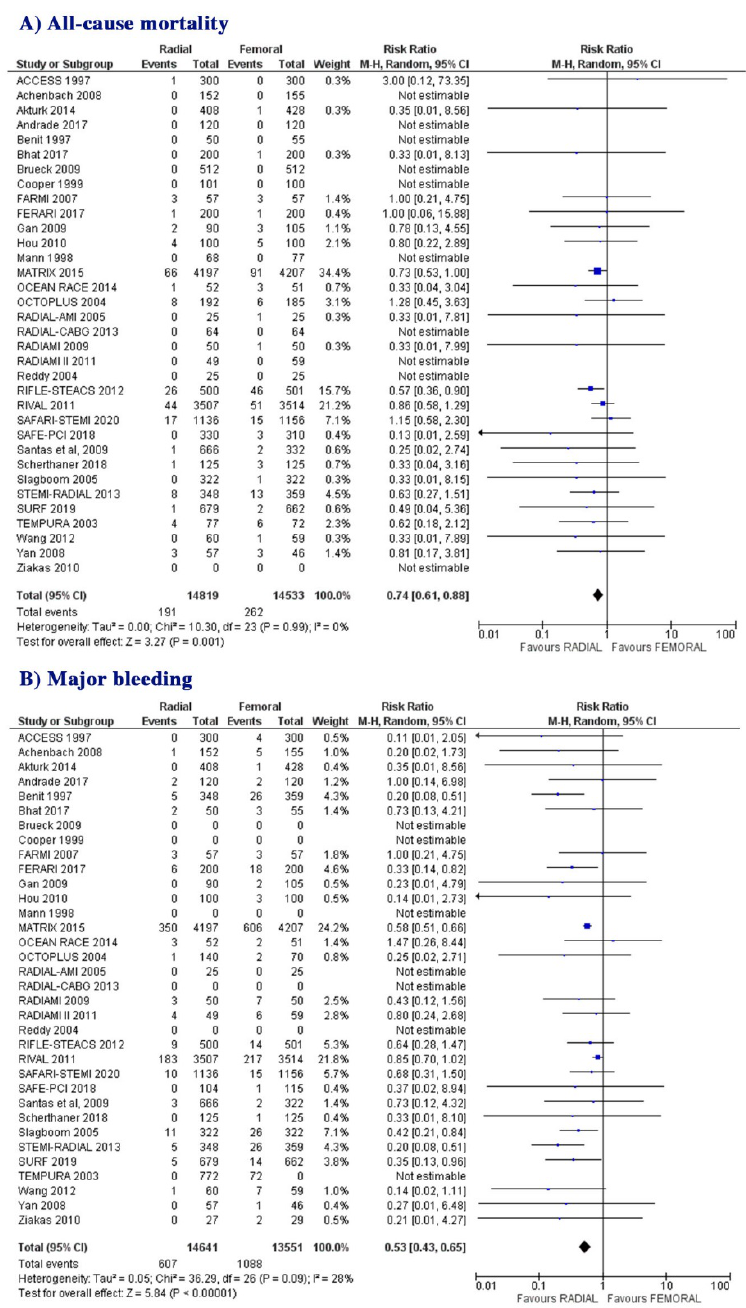
Figure 2. Risk of all-cause mortality ( A ) and major bleeding ( B ) at follow-up: radial vs. femoral, in whole group of patients.